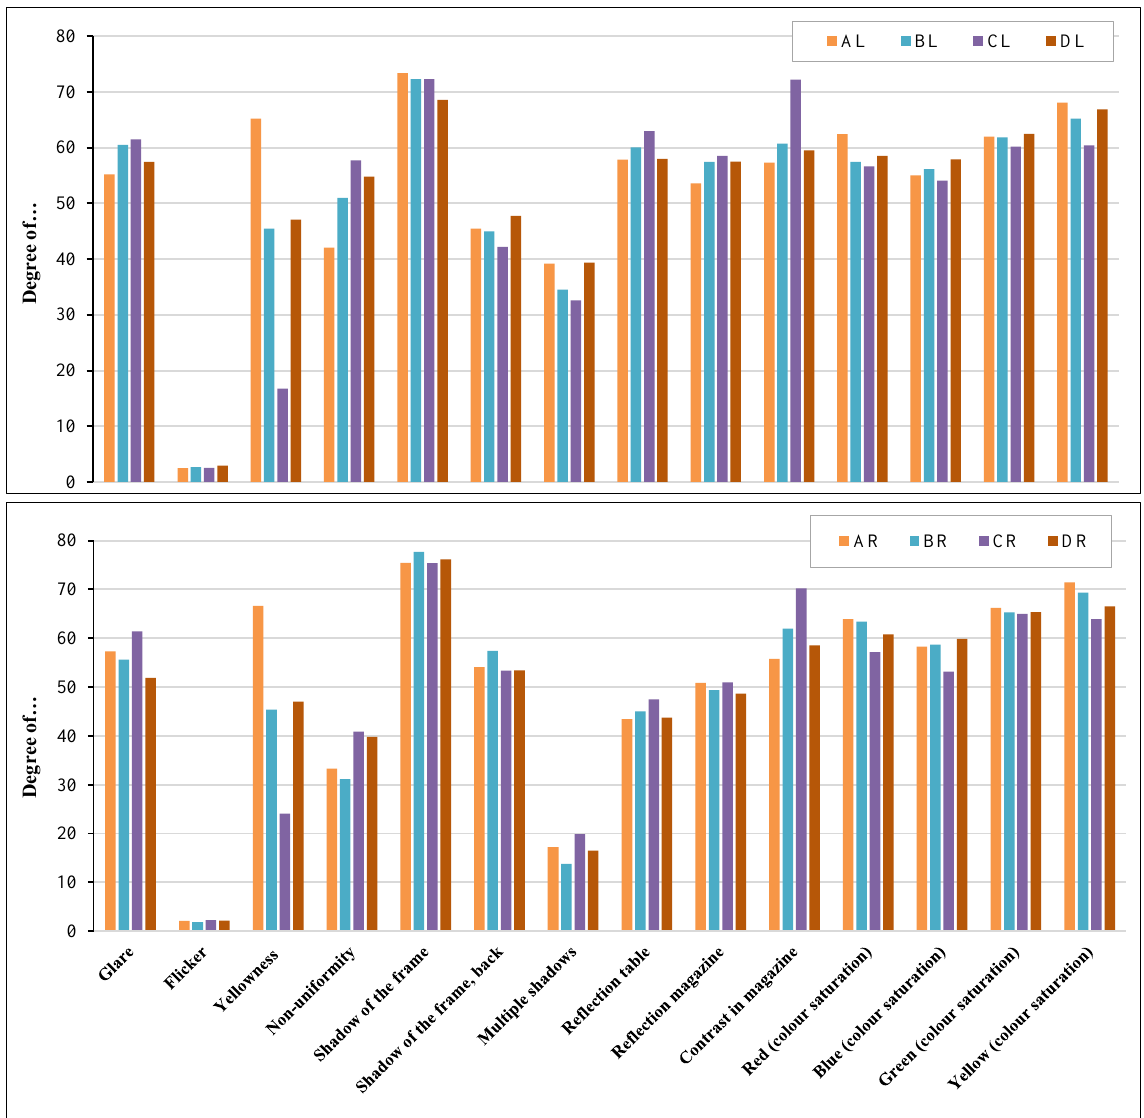
Figure 2. Mean values (on a scale 0-100) of the assessed attributes for four lighting products performed in laboratory settings (L, top graph) and in the real context (R, bottom graph). Lighting products sub-study 1: AL/R (2700 K, 510 lm), BL/R (3000 K, 560 lm), CL/R (4000 K, 600 lm), DL/R (3000 K, 340 lm, old